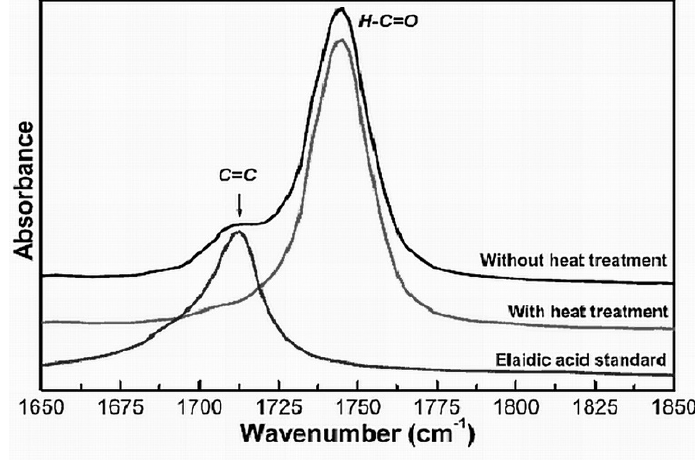
Figure 2. Expansion of the FTIR spectra in order to observe the cis double bonds.